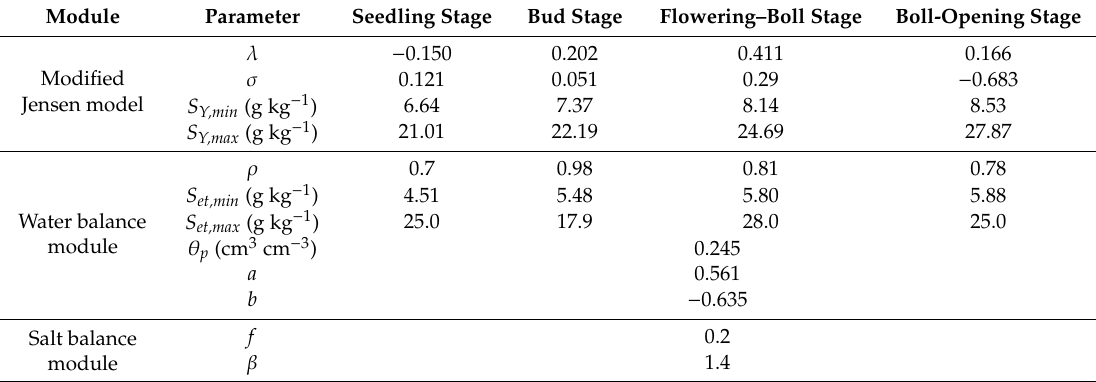
Table 1. Parameter fitting of the modified Jensen model and the soil water and salt balance modules.